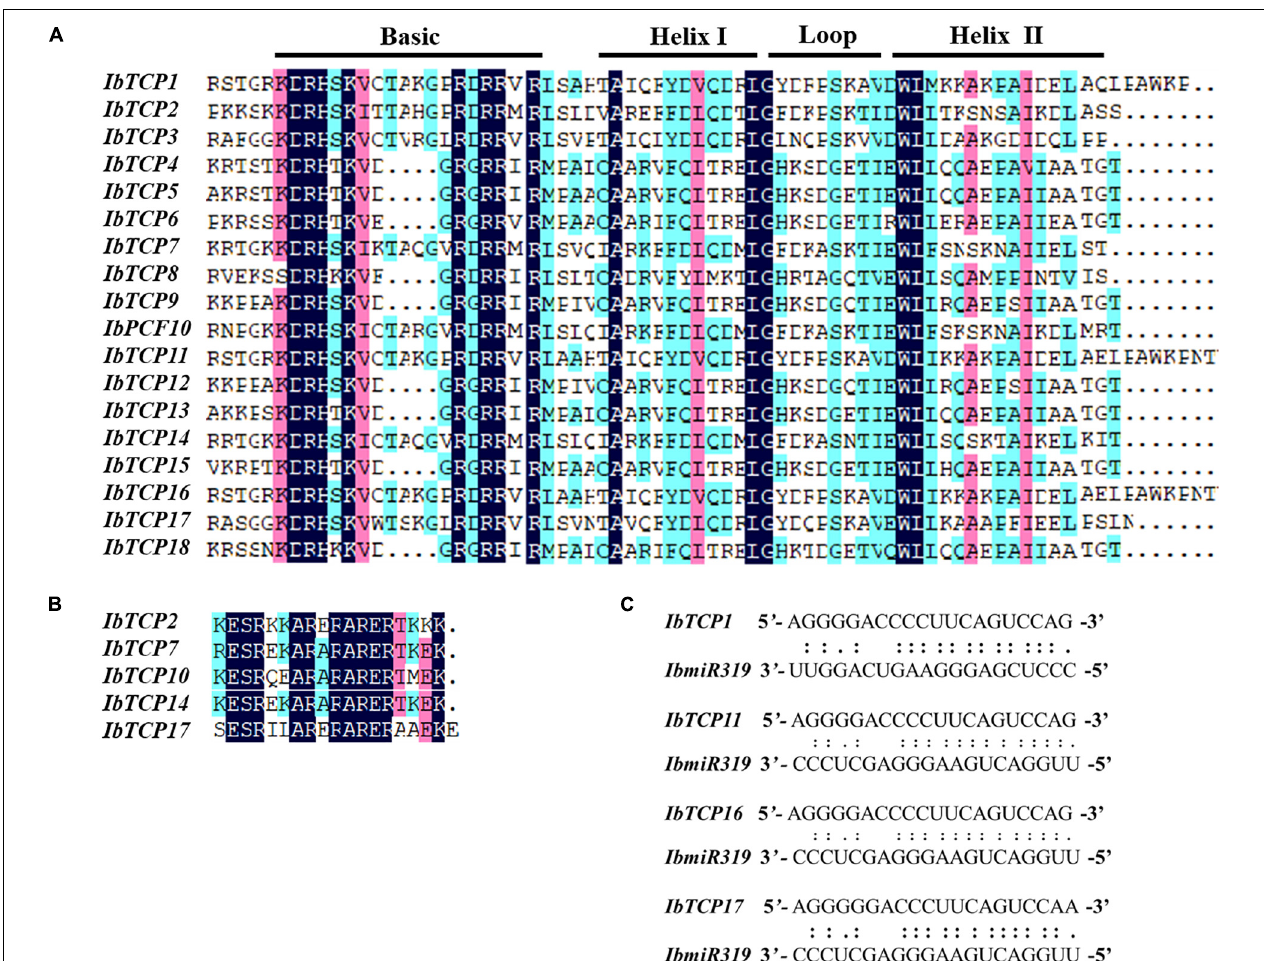
FIGURE 3 | Multiple sequence alignment of IbTCP proteins and the IbmiR319-targeted IbTCPs. (A) Alignment of the TCP domain of the 18 TCP proteins in sweet potato. Shaded in different colors indict the conserved amino acids. Conserved domains, including Basic, Helix I, Loop, and Helix II, are shown at the top. (B) Alignment of the R-domain of the class II members. Shaded in different colors indict the conserved amino acids. (C) Complementarities of IbmiR319 and its target IbTCP1 , IbTCP11 , IbTCP16 , and IbTCP17